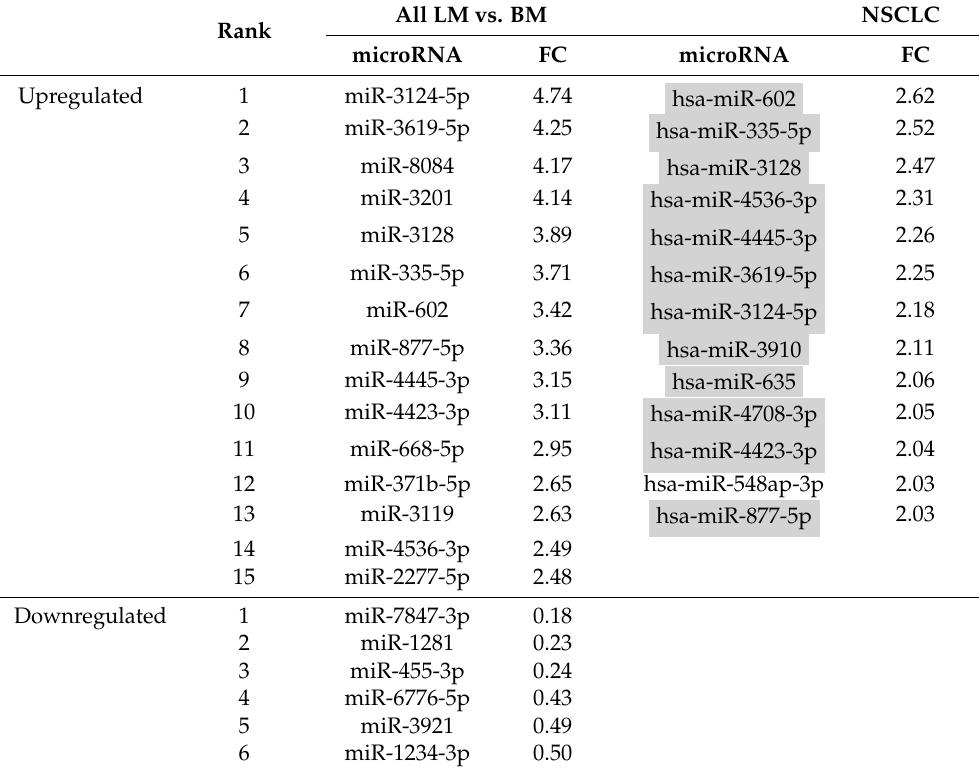
Table 3. Representative differentially expressed extracellular microRNAs in CSF of leptomeningeal metastases compared to brain metastases. All LM vs. BM Rank